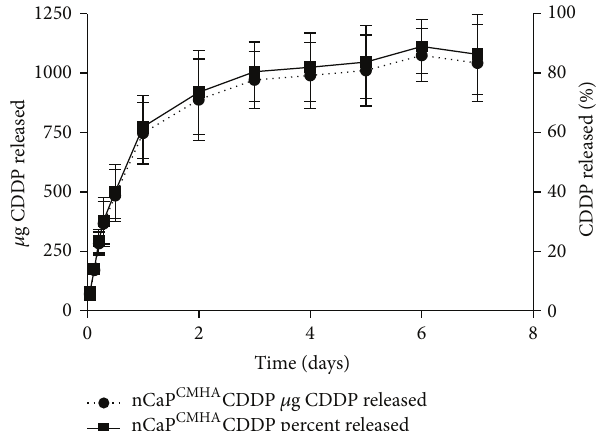
Figure 3: In vitro release testing of nCaP CMHA CDDP using a modified USP Apparatus 4. Release was conducted in 10 mM PBS pH 7.4, 0.1% sodium azide at 37 ∘ C. The left axis is cumulative CDDP released with percent CDDP released on the right 𝑦 -axis. The formulation provides sustained delivery of CDDP for 2 days under these infinite sink conditions. After 2 days nCaP CMHA CDDP released 74% of the total CDDP bound. At day 7, nCaP CMHA CDDP released an average of 86% of the total CDDP